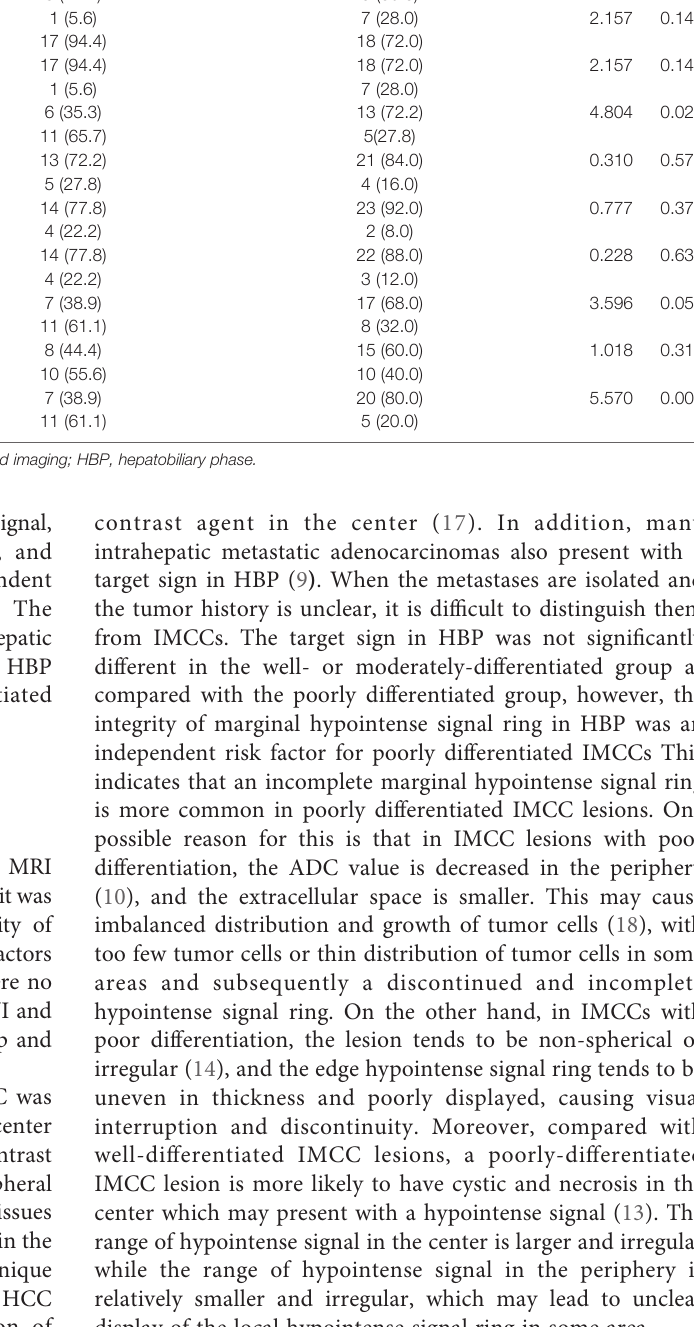
pathological grade Poorly differentiated (n = 18) Well- or moderately-differentiated (n =